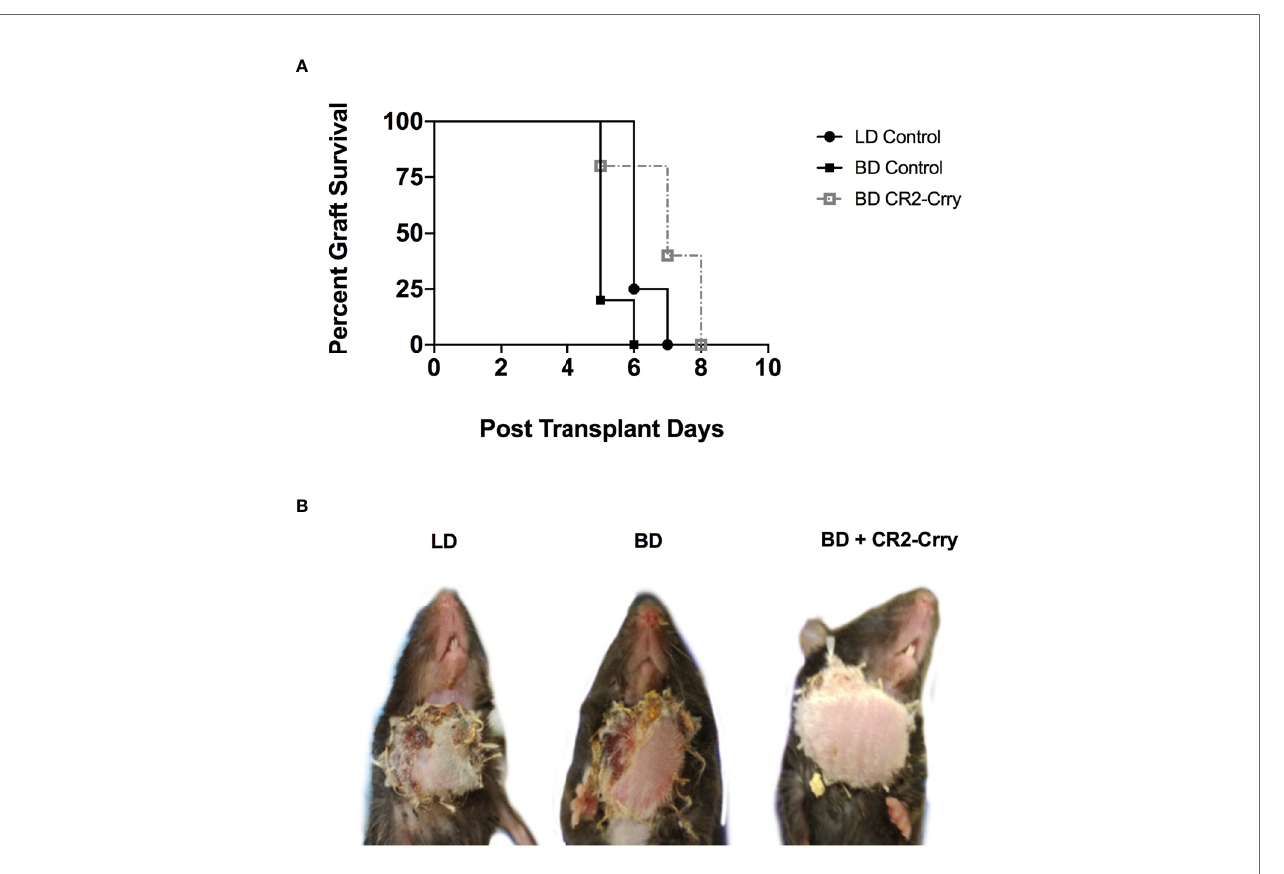
FIGURE 7 | Impact of BD and CR2-Crry BD donor pre-treatment on VCA survival. (A) VCA graft survival curve. (B) Representative images of recipient mice at day 5 post-Tx. Logrank tests comparing survival across the 4 groups demonstrated survival times were signi fi cantly different between groups (p < 0.0001). All pairwise comparisons demonstrated that survival was signi fi cantly greater among each group when compared to the BD group (for LD vs BD, and for BD vs BD+CR2-Crry), even after a Holm-Sidak adjustment for multiple comparisons. No signi fi cant difference was seen between living BD or BD+CR2-Crry. (n =